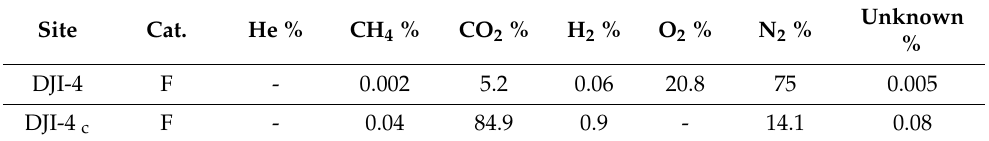
Table 5. Gas chromatography data from site 4, including non-corrected and air-corrected measurements.